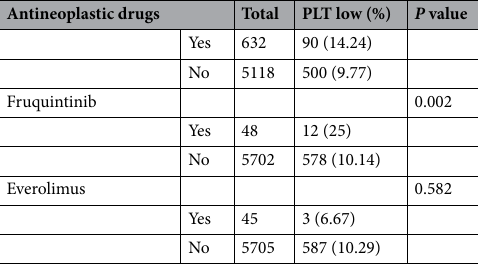
Table 3. Antineoplastic drugs based on chemotherapy cycles.